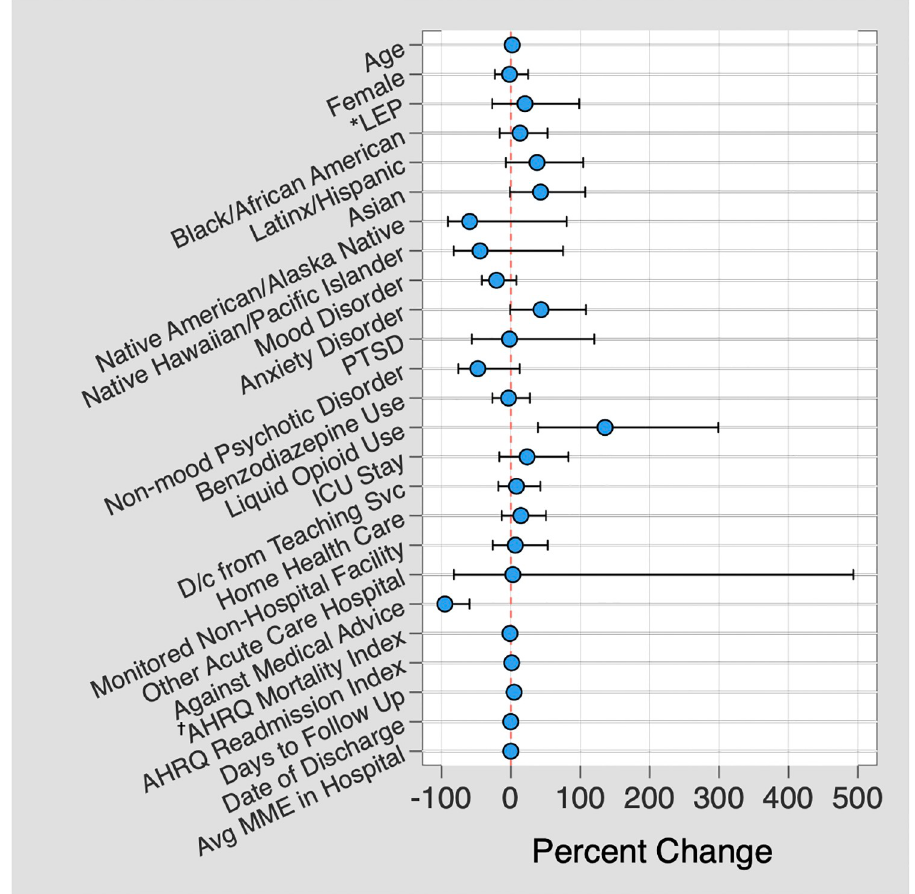
Fig 3. Predictors associated with high delta days. Multiple linear regression demonstrating predictors associated with a large difference in number of days prescribed between adjusted days and conventional days metrics, plotted against the percent difference between the two metrics. � LEP = Limited English proficiency; † AHRQ = Agency for Healthcare Research and Quality.